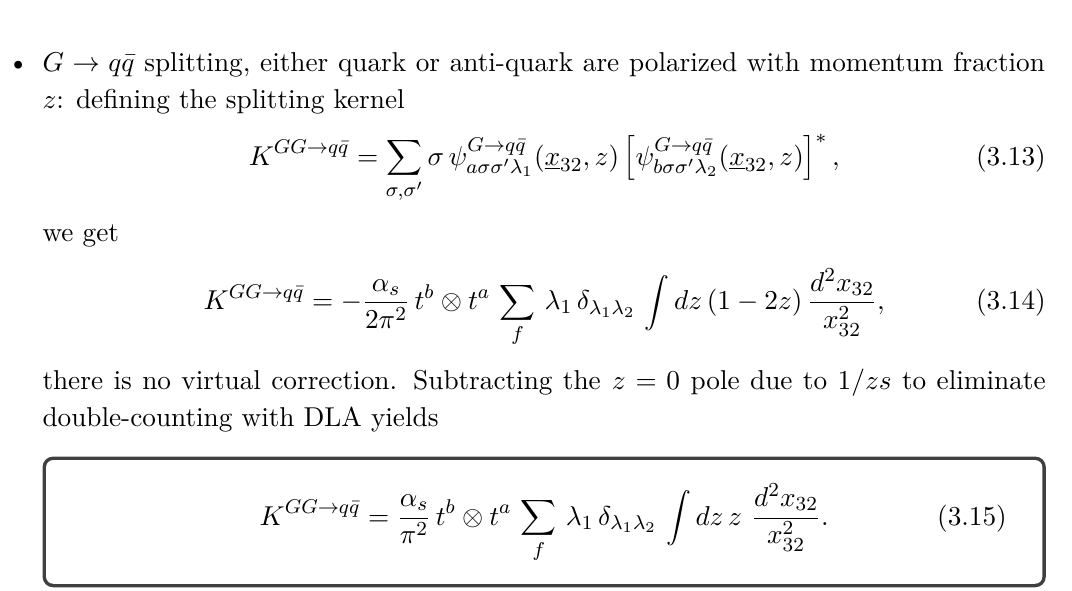
Figure 2 . The diagram contributing to the lowest-order light-cone wave function for the G → q ¯ q